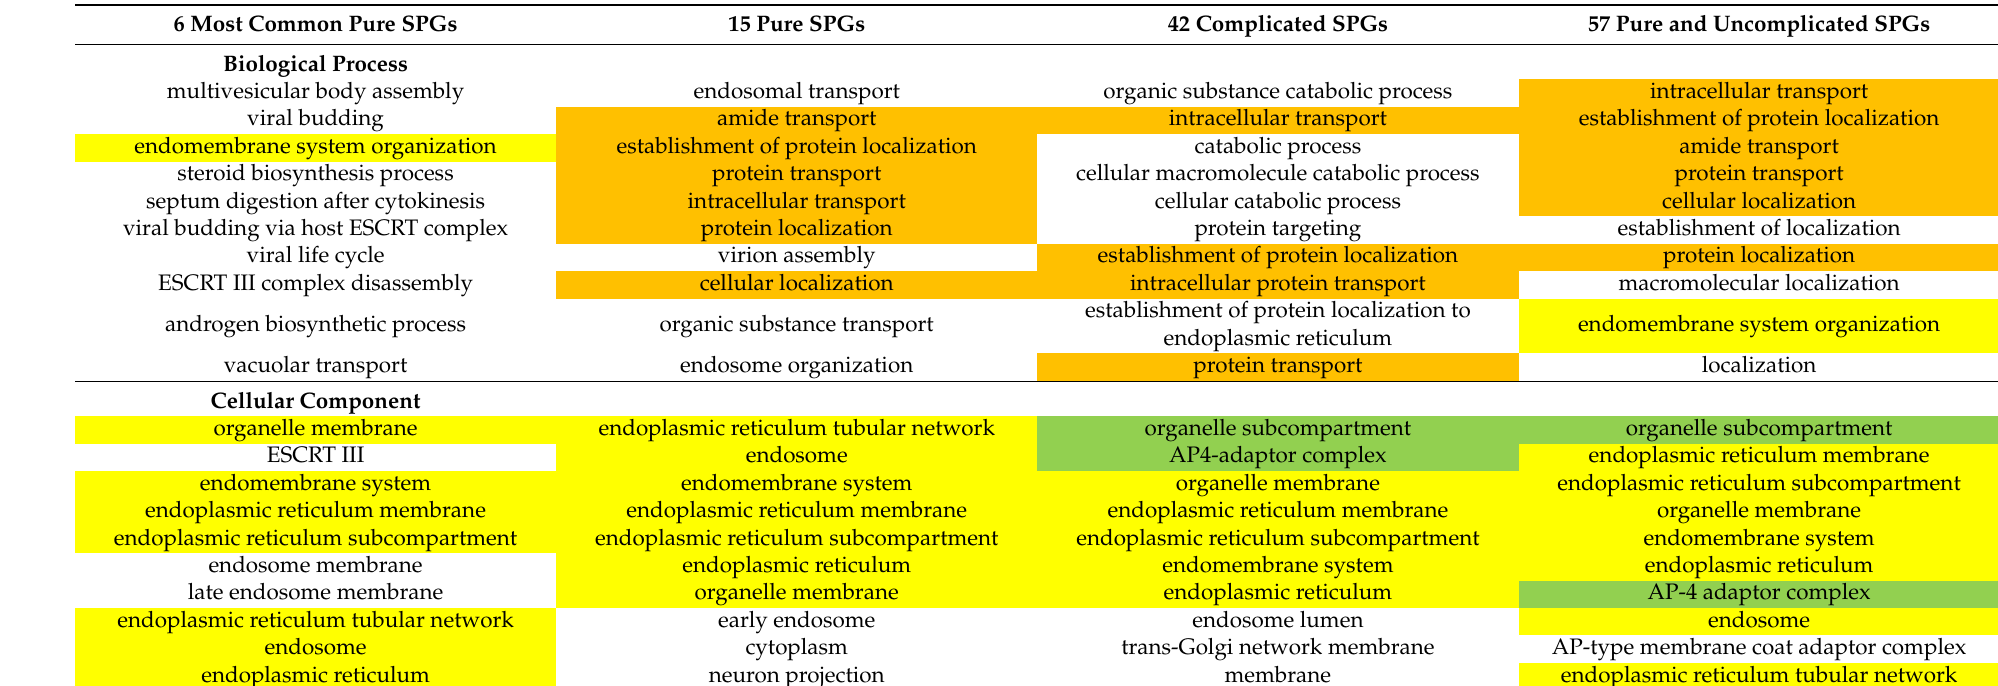
Table 3. GO terms of PPIs of second shell interactions (top ranked by